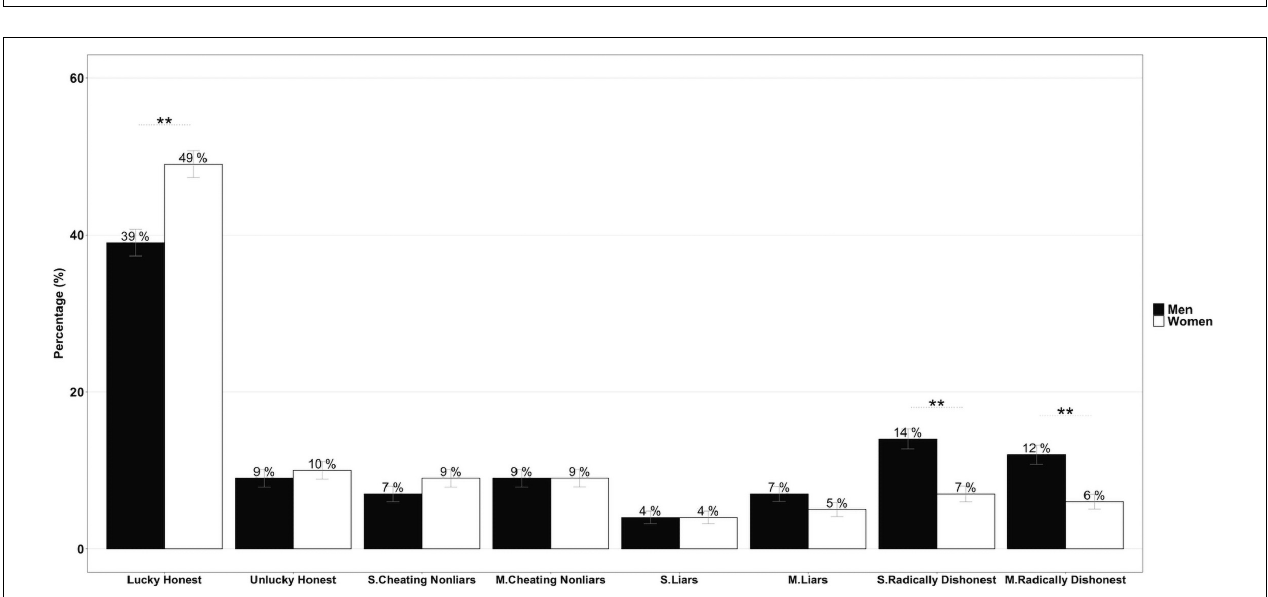
FIGURE 2 | Real die outcome (men vs. women). Proportion test confidence interval at 95% is represented in gray.